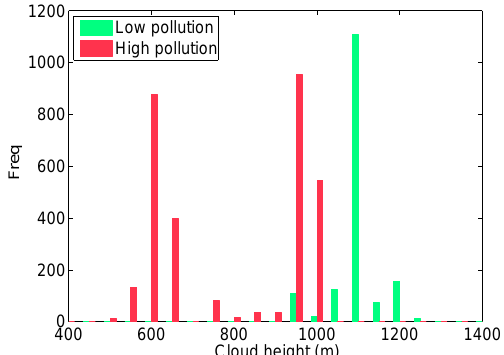
Figure 10. Altitude of cloud retrievals by MAC6 under low- (green) and high- (red) pollution cases, for five high-pollution and two low- pollution flights. Note that this figure shows the height at which the aircraft penetrated the clouds rather than cloud base or top height; however, the observations are consistent with overall lower cloud heights under polluted